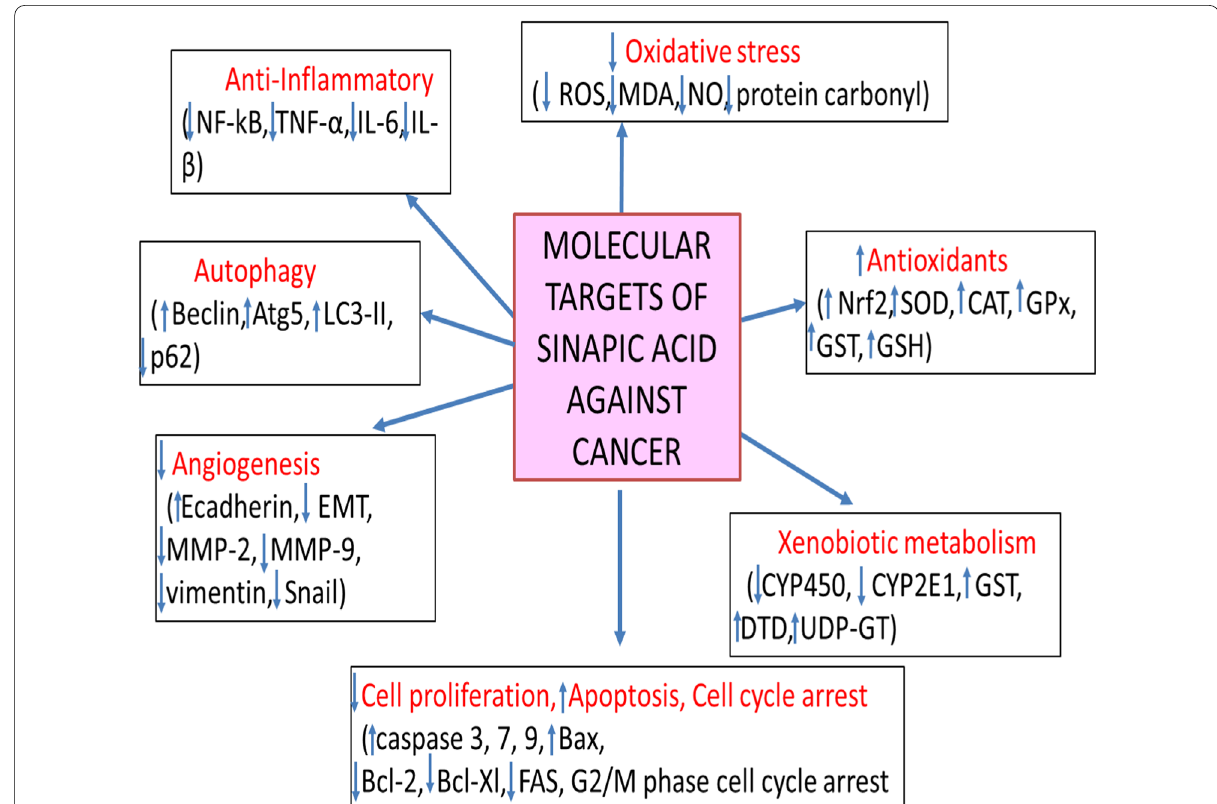
Fig. 2 Molecular targets of sinapic acid against